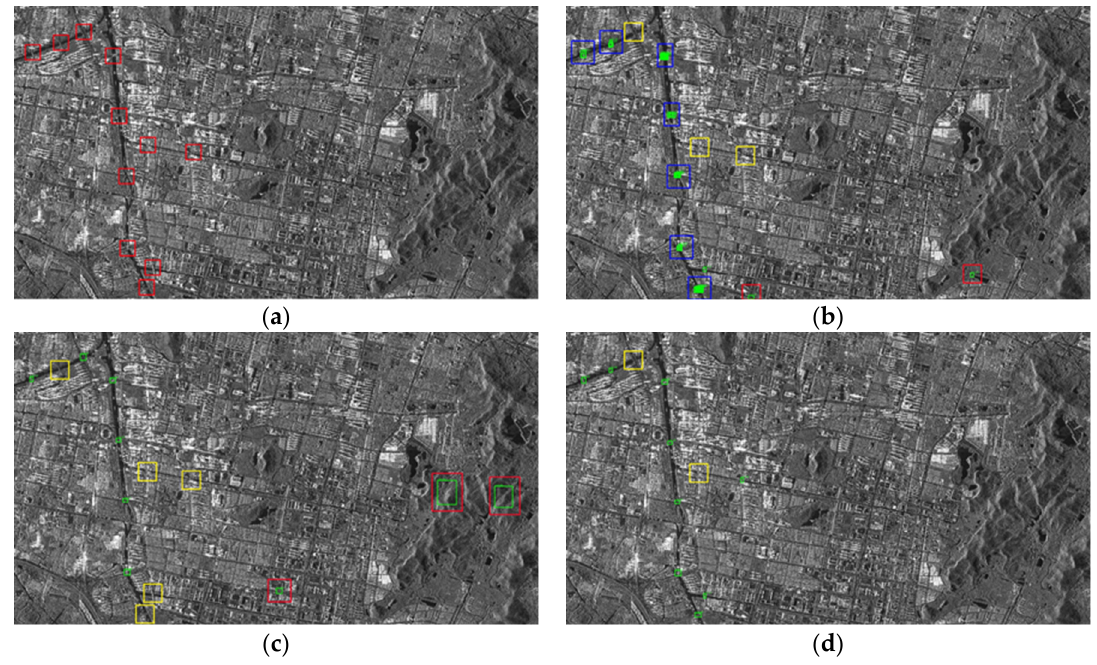
Figure 12. The detection results of bridges for Gaofen-3 image. ( a ) The ground truth of the bridges. ( b ) the detection results by Faster R-CNN. ( c ) the detection results by SSD. ( d ) the detection results by MABN.